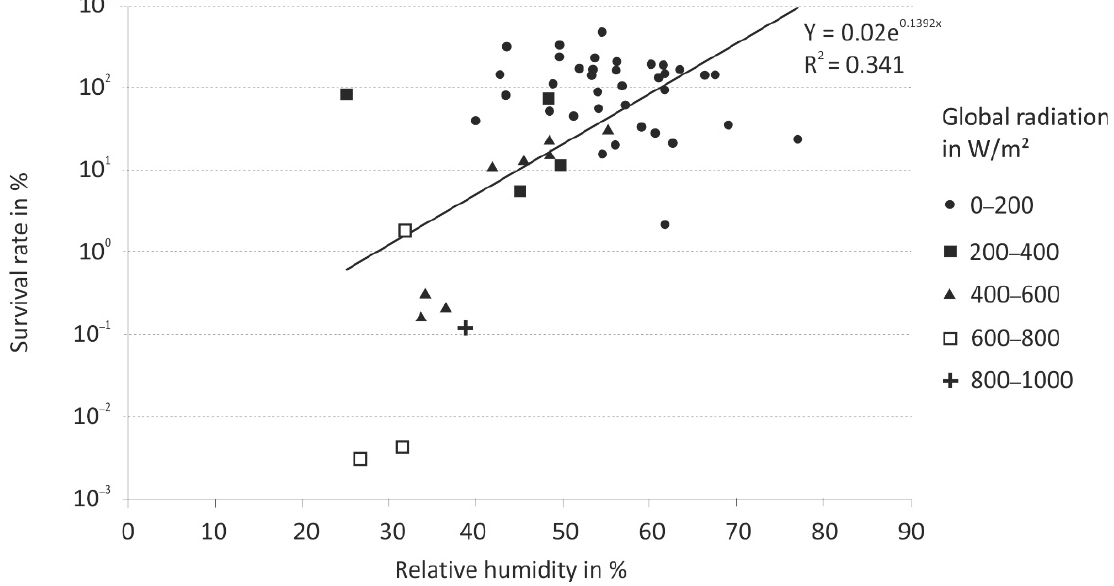
Figure 6. Survival rates of Staphylococcus xylosus after 12 min in the airborne state as a function of temperature and the influence of global radiation ( n = 54).